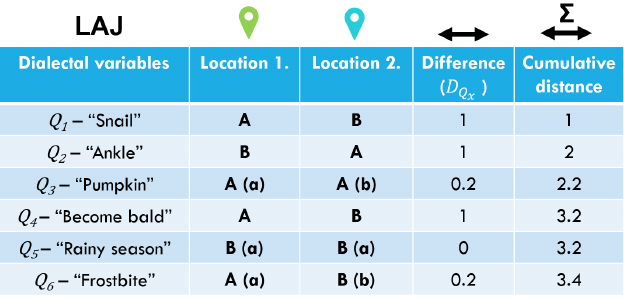
Figure 4. Calculation of the linguistic distance between two localities. Uppercase letters stand for the variant category while lowercase letters stand for the actual variant within the variant